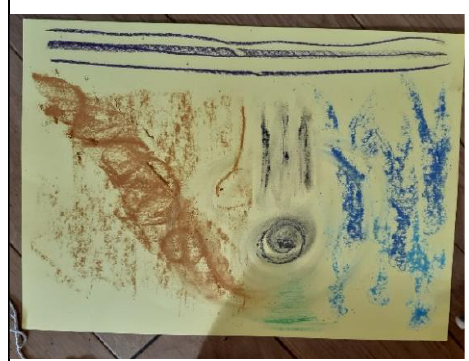
Figure 6. Holding it all together.